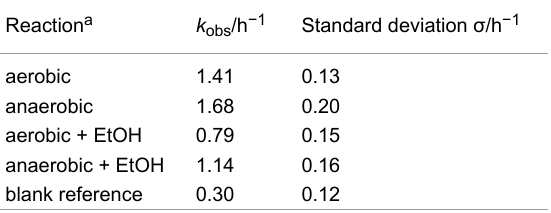
Table 1: Kinetic parameters for the photooxidation of indigo by com- pound 1 under aerobic/anaerobic conditions in the presence and absence of EtOH as hydroxyl radical scavenger.